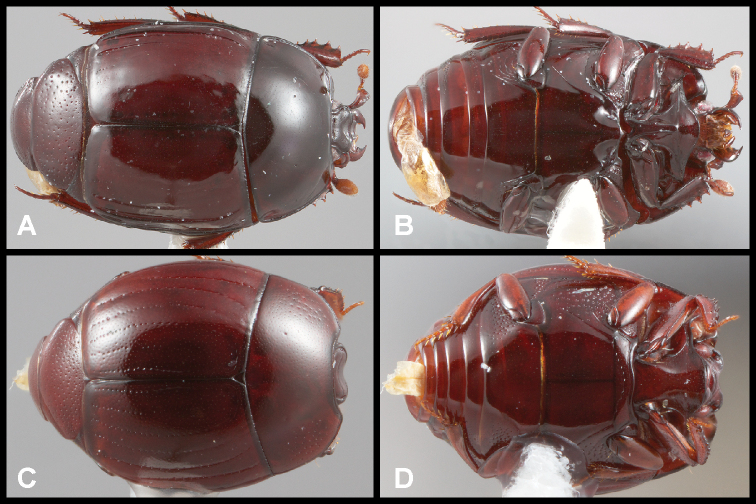
A, BPhelister
spectabilis: A dorsal habitus B ventral habitus C, DP.
pervagatus: C dorsal habitus D ventral habitus.